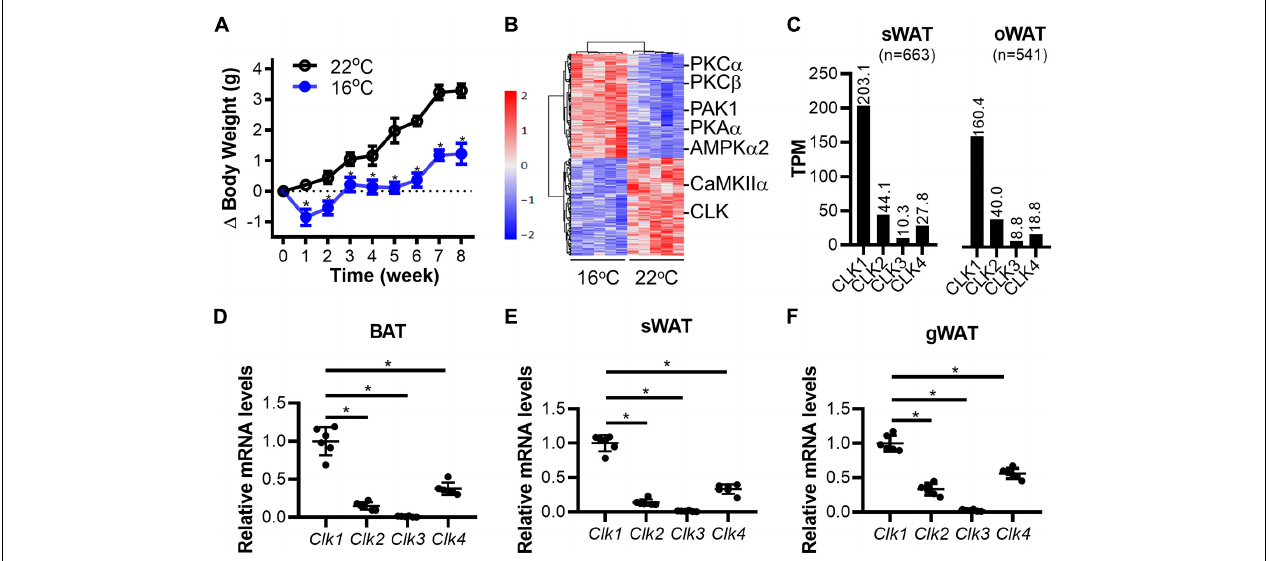
FIGURE 1 | Downregulation of CLK in brown adipose tissue in mice housed in a mild cold environment. (A) The body weight change of 8-week-old male mice fed a standard chow diet for 8 weeks in either 22 or 16 ◦ C environmental chambers. n = 6/group, data shown as mean ± SEM, * p < 0.05 vs 22 ◦ C. (Two-way ANOVA with Sidak’s multiple comparisons test). (B) At the end of the experiment described in panel (A) , the brown adipose tissue (BAT) in the interscapular region was collected and subjected to phosphoproteomics by LC-MS/MS. The hierarchical clustering and heatmap shows the sites differentially phosphorylated in response to mild-cold as determined in BAT. The color scale represents the relative abundance of sites. Further analysis identified CLK as one of the down-regulated family of kinases in interscapular BAT in mice housed at 16 ◦ C. n = 5/group. (C) Expression of the CLK family members in human subcutaneous (sWAT) and omental adipose tissues (oWAT). The data was adapted from the GTEx Portal (https://www.gtexportal.org/home/gene/CLK1). (D–F) The mRNA levels of the Clk family members (relative to 18S rRNA) in adipose tissues from interscapular (BAT), subcutaneous (sWAT) and gonadal (gWAT) regions of 8-week-old C57BL/6J mice on standard chow diet and housed at 22 ◦ C. The relative Clk1 mRNA levels in adipose tissues were set as 1, n = 6/group, data shown as mean ± SD, * p < 0.05 vs Clk1 . One-way ANOVA with Sidak’s multiple comparisons